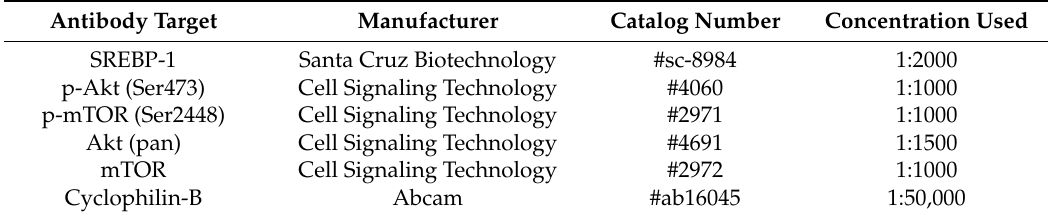
Table 1. Primary antibodies used for Western